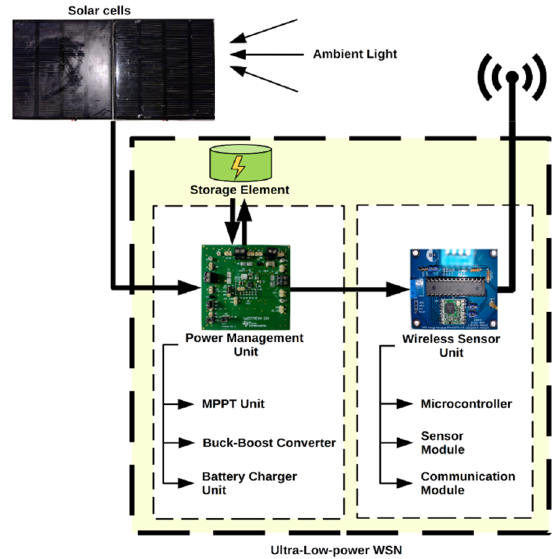
Figure 4. The proposed ultra-low-power WSTx system diagram.